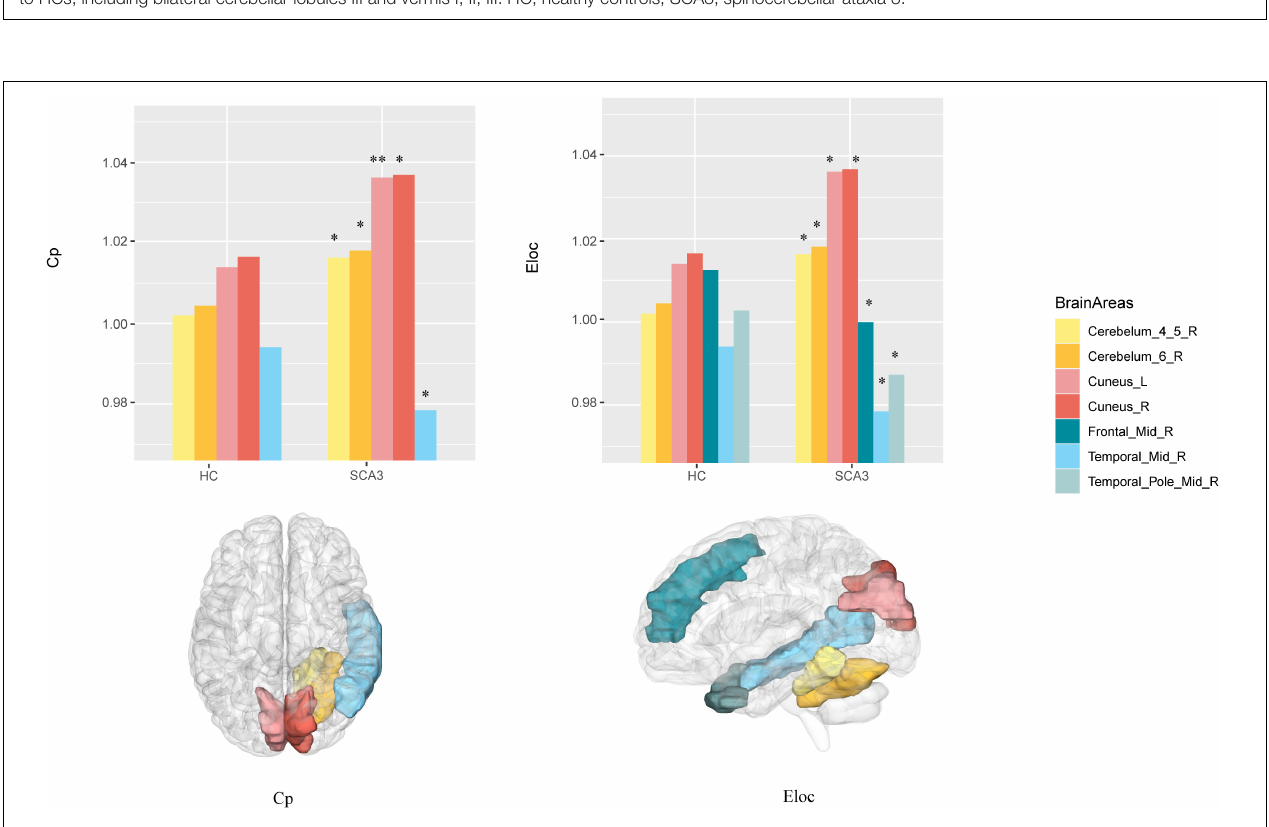
FIGURE 3 | Brain Areas that significantly differ in nodal properties between the two groups. Cerebellum_4_5_R, right cerebellar lobule IV–V; Cerebellum_6_R, right cerebellar lobule VI; Cuneus_L, left cuneus; Cuneus_R, right cuneus; Frontal _Mid_R, right middle frontal lobe; Temporal_Mid_R, right middle temporal lobe; Temporal_Pole_Mid_R, right middle temporal pole; The P -values were corrected using FDR correction. Warm colors (yellow, orange, pink, red) represent an increased index, while cold colors (green, blue) represent a decreased index in SCA3 compared to HC. ∗ , P FDR < 0.05; ∗∗ , P FDR < 0.01.